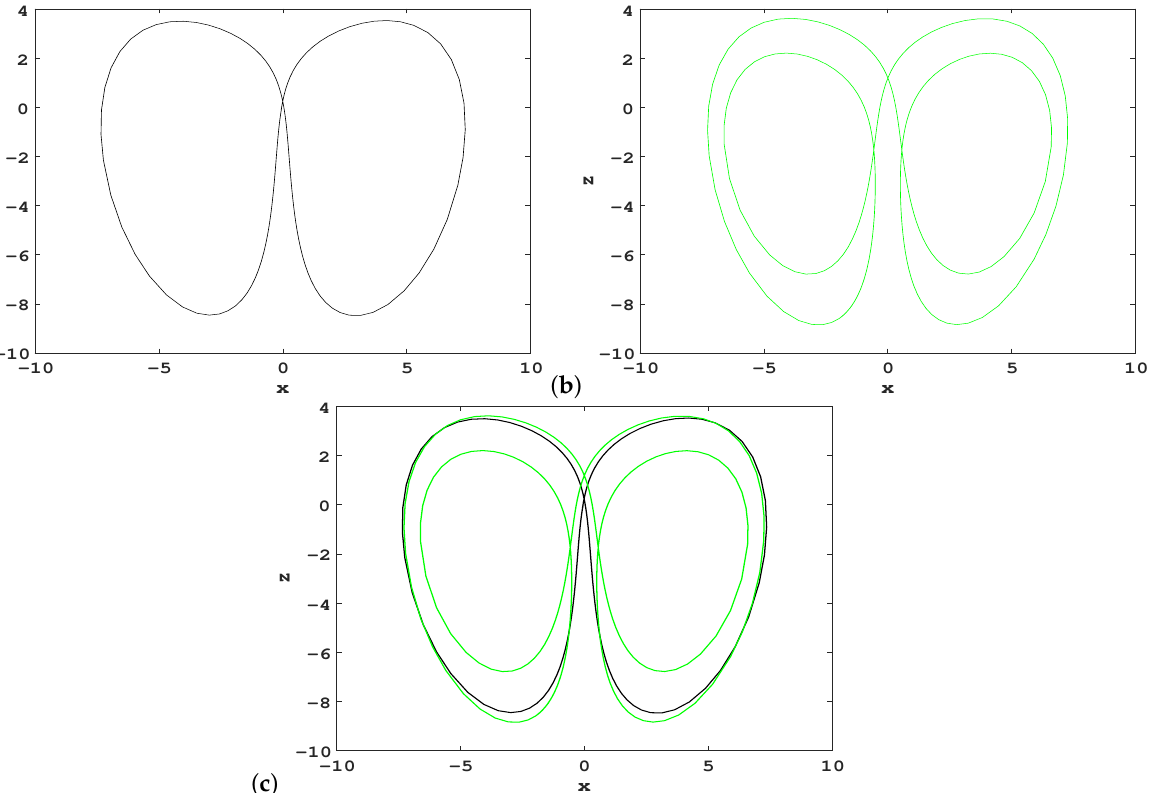
Figure 11. Two coexisting hidden periodic attractors of system (2); ( a , b , c , k , m ) = ( 10,10,2.7, − 0.2,2 ) ; ( a ) periodic attractor; ( b ) another periodic attractor; ( c ) coexisting periodic attractors. The black line and the green line correspond to the periodic attractor shown in ( a , b ),